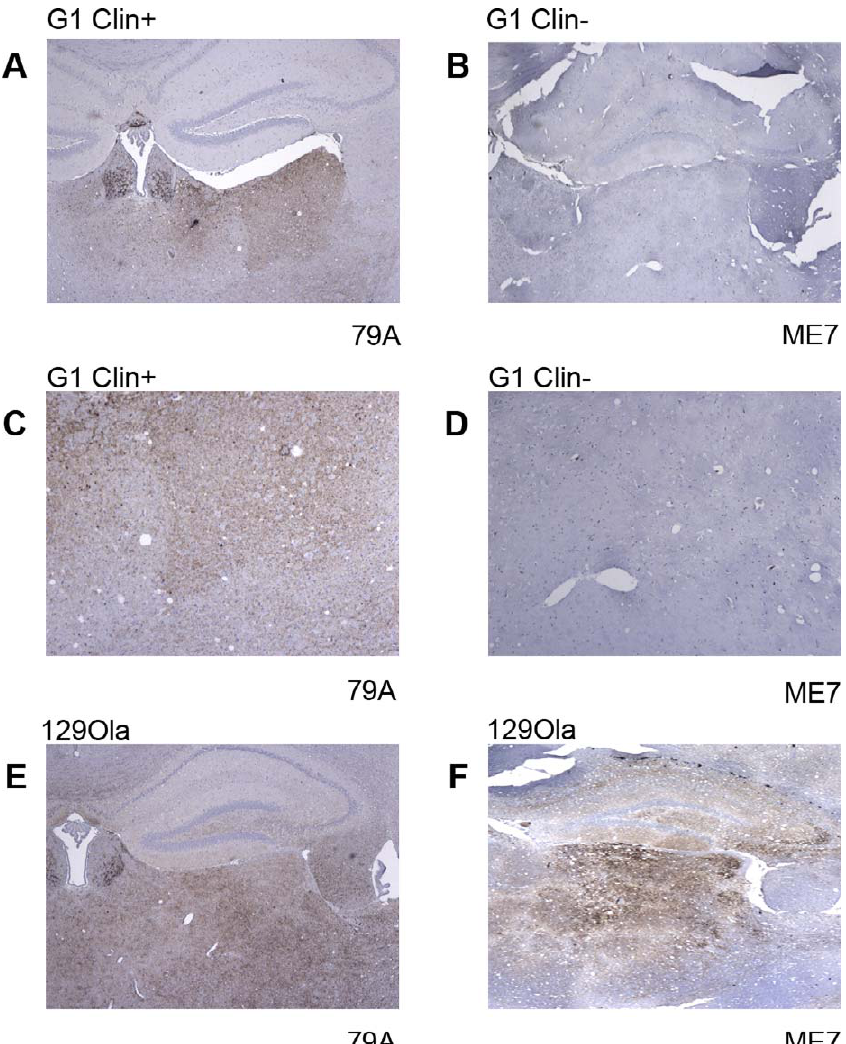
Figure 6. Immunohistochemical Analysis of Brain from G1 Mice Inoculated with TSE Strains 79A and ME7 Brain sections were immunostained for PrP using monoclonal antibody 6H4 and analysed by light microscopy using a Nikon Eclipse E 800 microscope. Widespread PrP immunopositivity is seen mostly in the thalamus (A and C) of clinically positive, symptomatic, G1 mice inoculated with 79A, absence of PrP-immunopositivity in the hippocampus (B) and thalamus (D) of clinically (Clin) negative, asymptomatic, G1 mice inoculated with ME7, (E) widespread PrP deposition in the thalamus and hippocampus of a wild-type mouse (129/Ola) after inoculation with 79A; (F) widespread PrP deposition in the thalamus of a wild-type mouse with neurological signs after inoculation with ME7. Magnifications: (A), (B), (E), and (F), 4 3 ; (C) and (D), 10 3